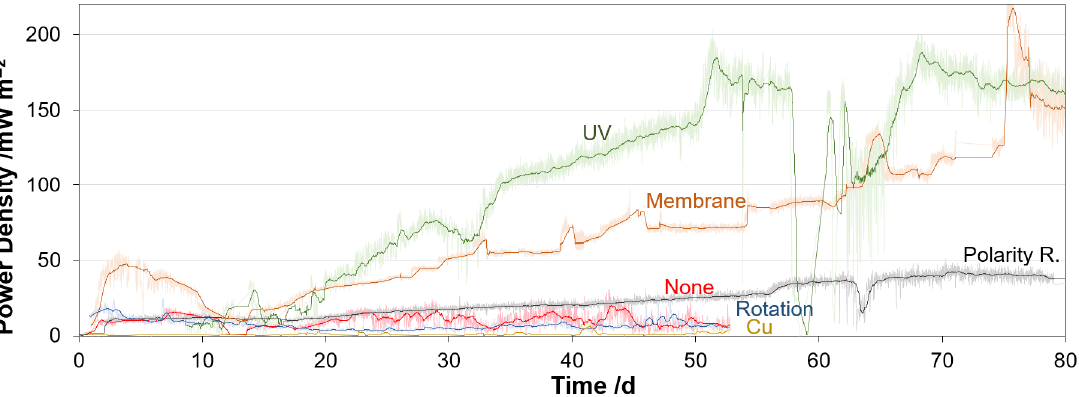
Figure 4. Development of power densities over time within 80 days for the anti-fouling strategies UV-irradiation, membrane addition, polarity reversal, rotation speed and copper layer addition compared to untreated GDE.